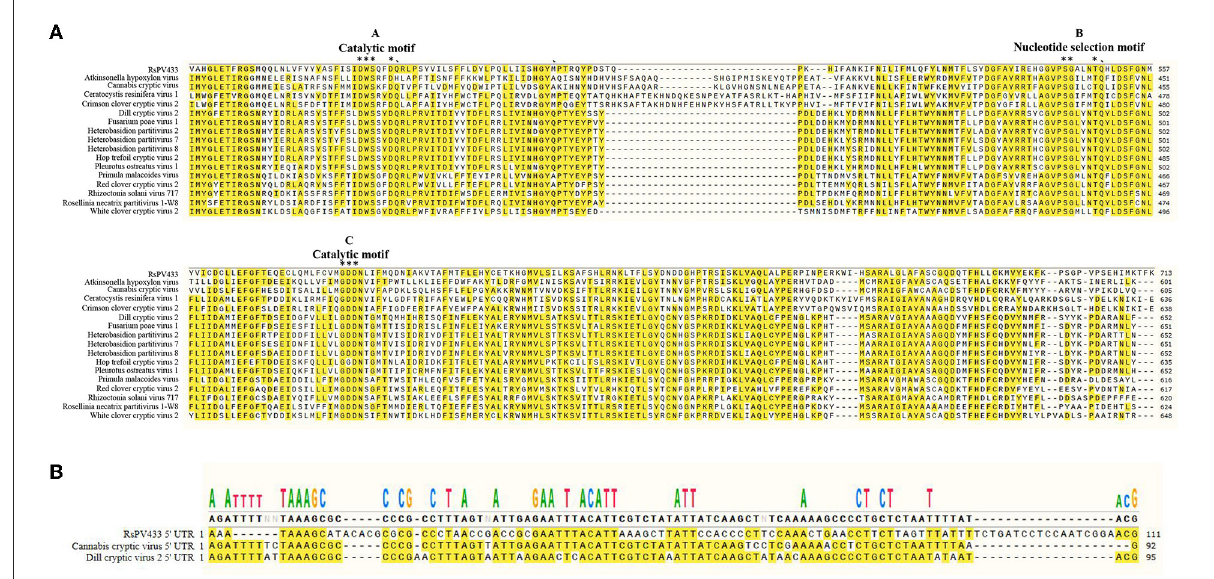
FIGURE3 Sequence similarity analysises of RsPV433 and its relative species. (A) Multiple amino acid sequence alignment of RdRps of RsPV433 and other related mycoviruses in Betapartitivirus . The A-, B-, and C-motif were conserved motifs that exist in all RdRps of dsRNA viruses (Te Velthuis, 2014). (B) Nucleotide sequence alignment of the 5 ′ UTR of RsPV433 and two relative viruses ( Cannabis cryptic virus and Dill cryptic virus ).